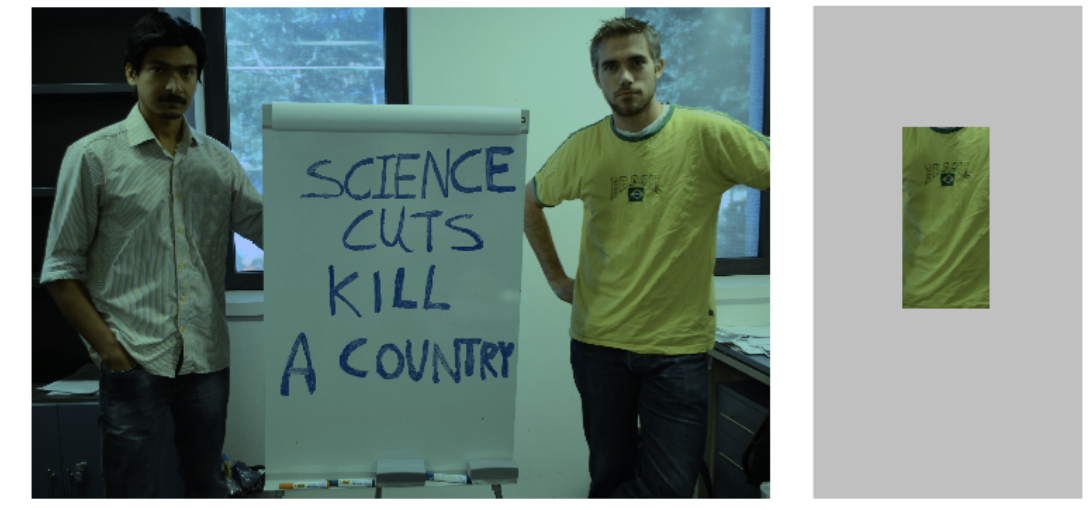
Figure 1. Example of color constancy. We are able to perceive the t-shirt of the man in the right as yellow, but, when looking at it in isolation the color of the t-shirt appears